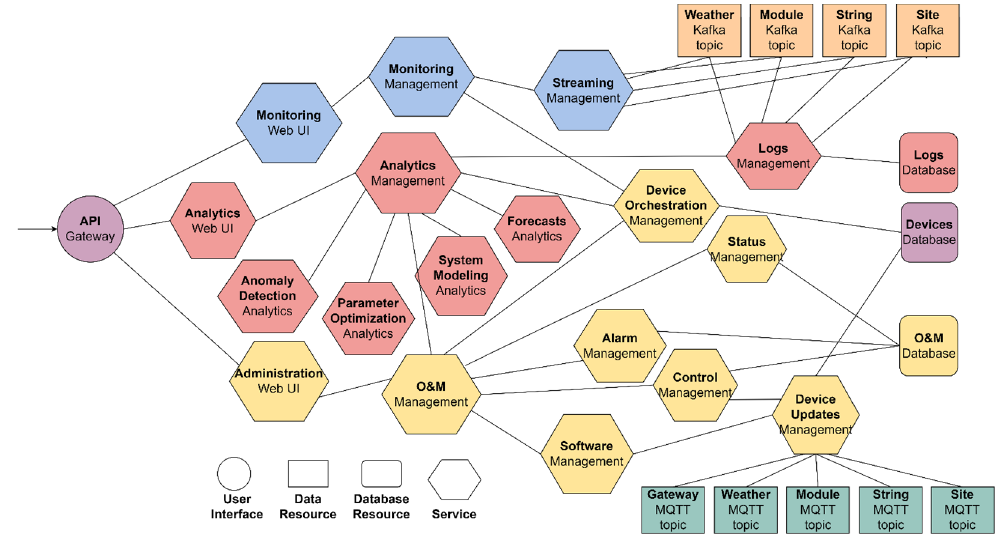
Figure 10. Microservices architecture.